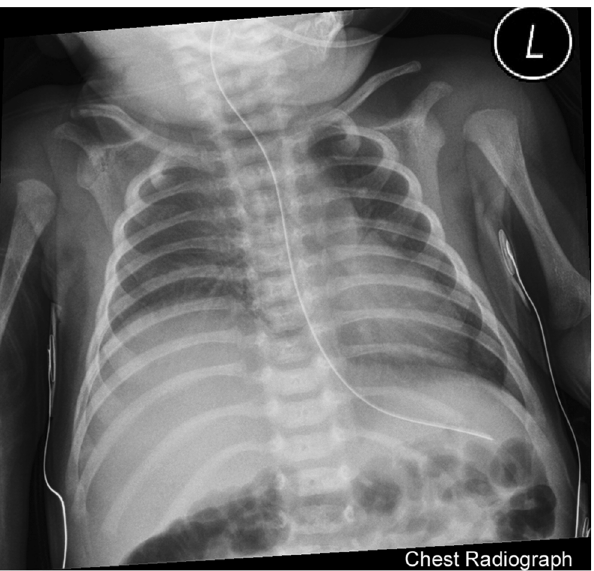
Fig. 15 Neonatal Phrenic Nerve Palsy Chest radiograph of a 3-week-old with history of shoulder dystocia shows elevated right dome of diaphragm relative to left. Subsequently performed real-time ultrasound of the diaphragm (not included) revealed diminished excursion of the right hemidiaphragm relative to the left